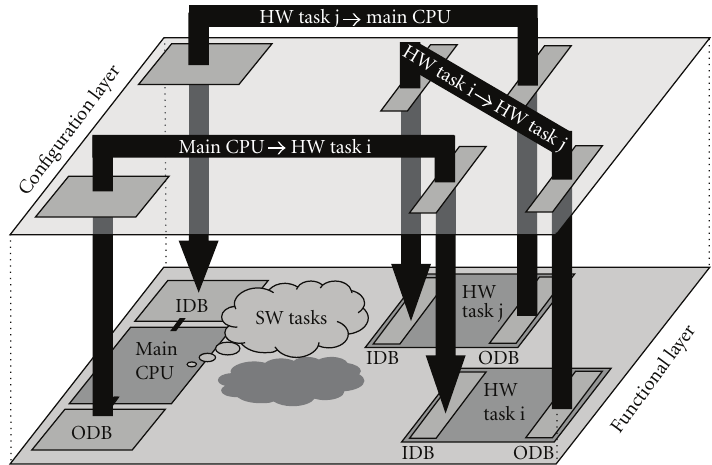
Figure 1: Hardware-software intertask communications using ICAP-based “virtual” channels.